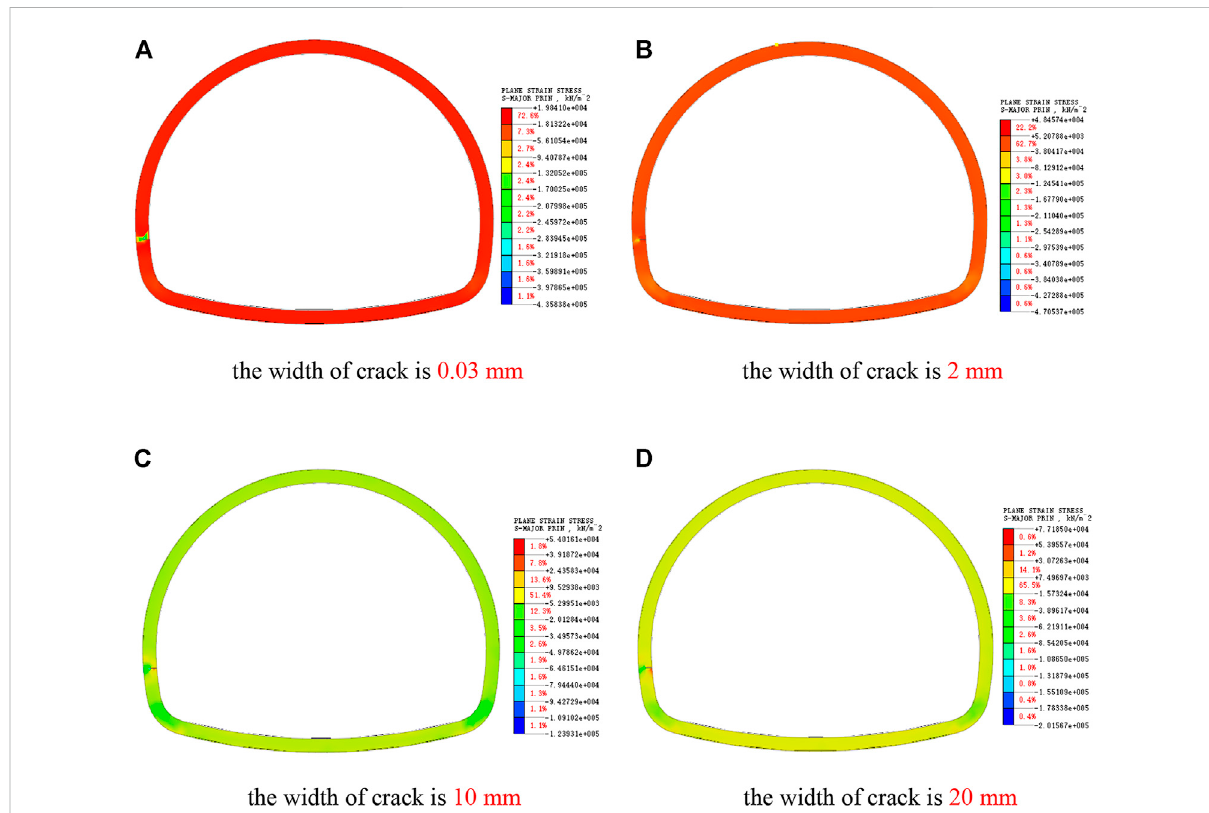
FIGURE 11 Cloudpictureofmaximumprincipalstressofsidewallcracks. (A) Thewidthofcrackis0.03 mm. (B) Thewidthofcrackis2 mm. (C) Thewidthof crack is 10 mm. (D) The width of crack is 20 mm.